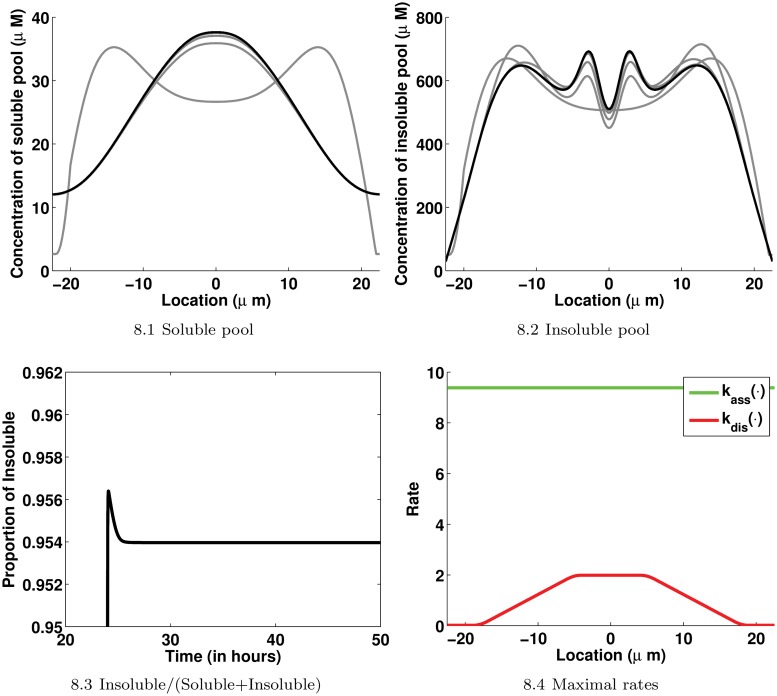
Details about the best model Scenario 21.8.1: Snapshots from 24 hours (gray) to 48 hours (black) taken every 30 minutes of the profile of the soluble pool over the cell. 8.2: Snapshots from 24 hours (gray) to 48 hours (black) taken every 30 minutes of the profile of the insoluble pool over the cell. 8.3: The distribution of the keratin material between the soluble and insoluble pools over time. 8.4: The profiles of assembly and disassembly maximal rates used with the Michaelis-Menten type turnover terms in Scenario 21. The estimates are k
ass = 9.3819μM/s, k
S = 570.73μM, k
dis = 0.9998μM/s leading to k
max = 1.976μM/s in (16) and k
I = 976.07μM/s.